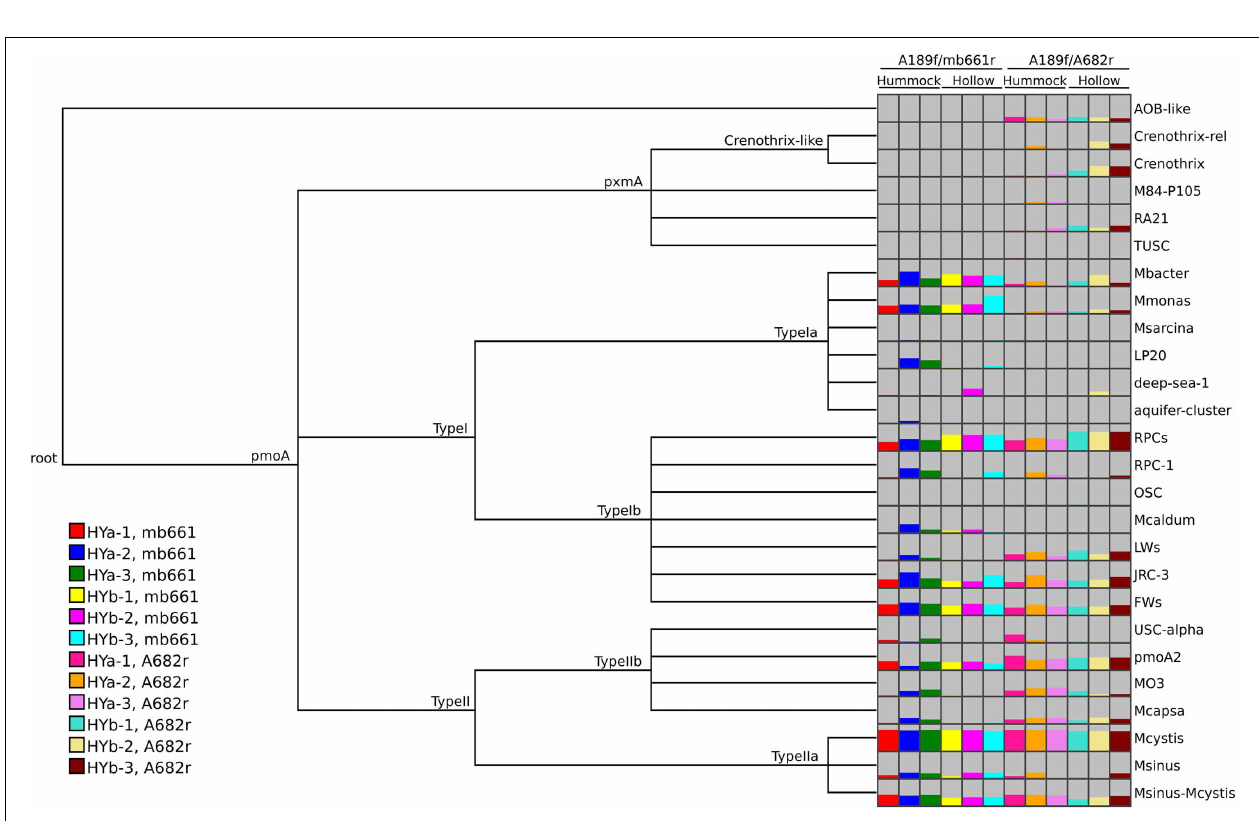
FIGURE 5 | MEGAN comparison view of pmoA classifications from the Riganqiao pmoA pyrosequencing datasets (Deng et al., 2013). The pmoA datasets were obtained from triplicate samples from hummock (HYa) and hollow (HYb) sites. PCRs were performed with two primer combinations (A189f/A682r or A189f/mb661r), as indicated. The option to subsample